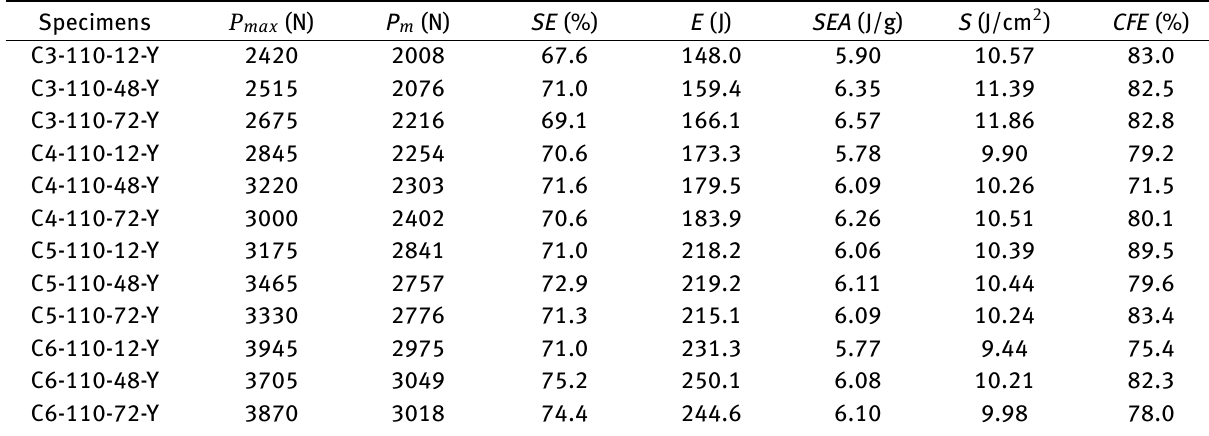
Table 3: Cushioning energy absorption of paper corrugation tubes along Y direction